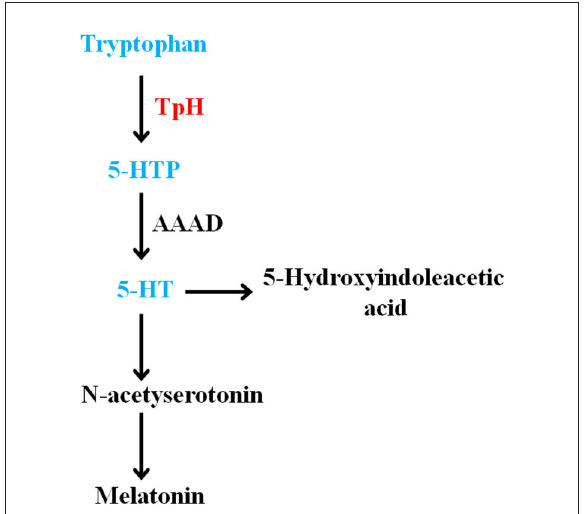
FIGURE5 Summary of the olfactory bulb metabolites involved in the disturbance of tryptophan-5-HT pathway in chronic mild stress mice. 5-HT, 5-hydroxytryptamine; 5-HTP,